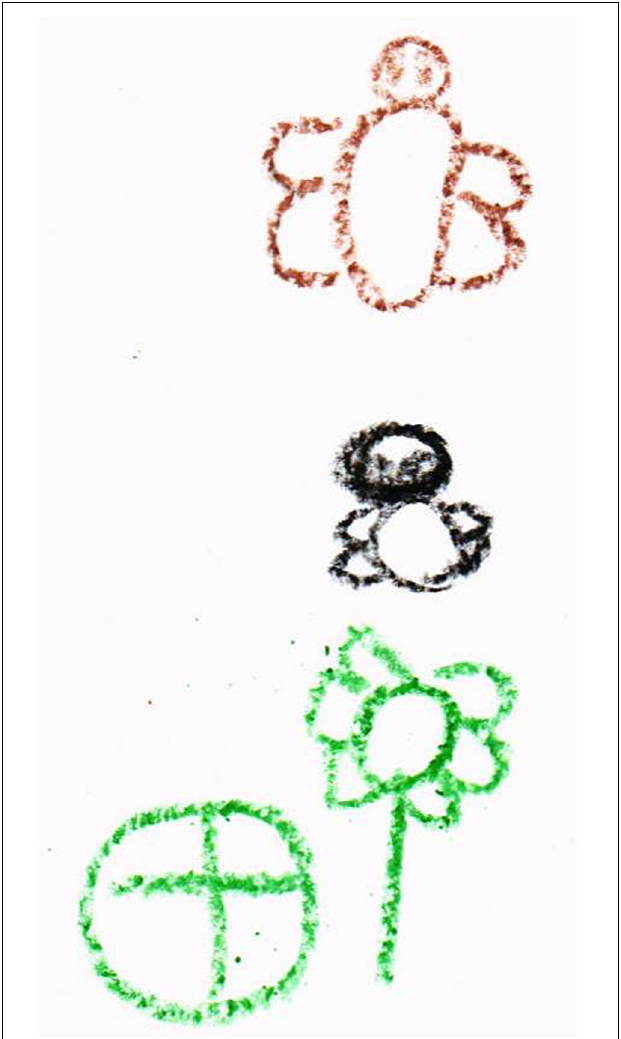
FIGURE 1 | Categorized drawings. FIGURE 2 | Drawing without proper symbolic